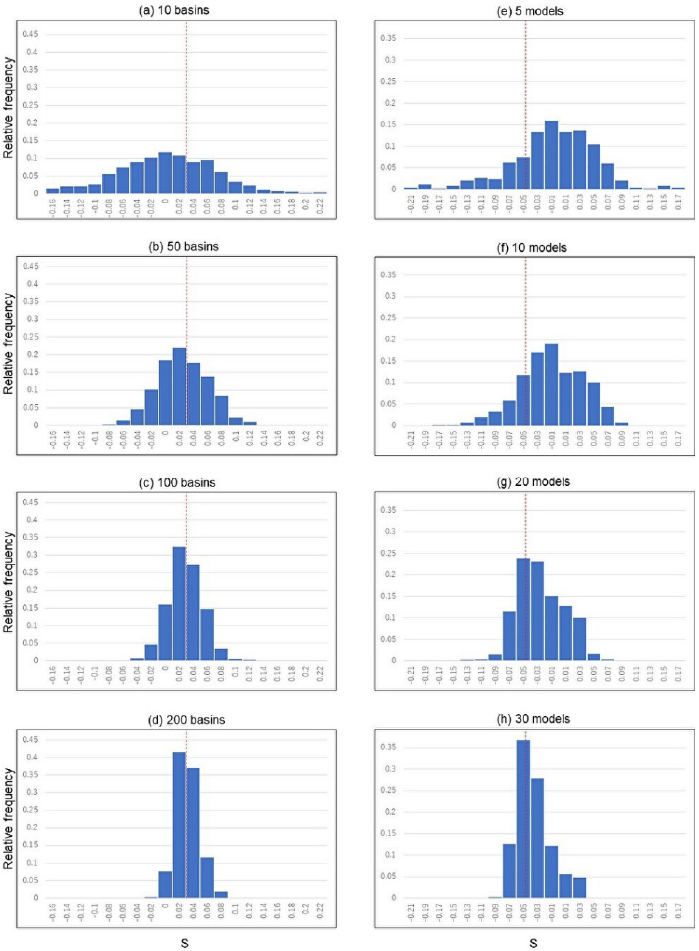
Figure 6. Histogram by bootstrapping of the number of basins and the number of models. The basins were randomly selected as ( a ) 10, ( b ) 50, ( c ) 100, and ( d ) 200 basins. The models were randomly selected as ( e ) 5, ( f ) 10, ( g ) 20, and ( h ) 30 models. Each random selection was repeated 1000 times, and the relative frequencies of the MME performance evaluation index S are shown. The red line shows the index S calculated with all basins and all models.